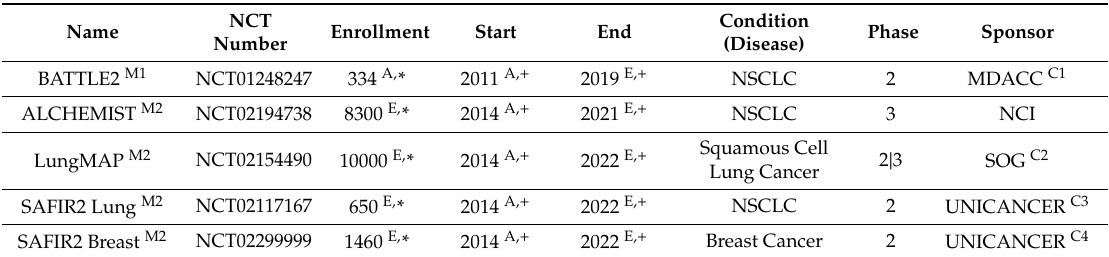
Table 3. Summary of randomized histology-specific studies examined in this article. Data extracted from clinicaltrials.gov (October,